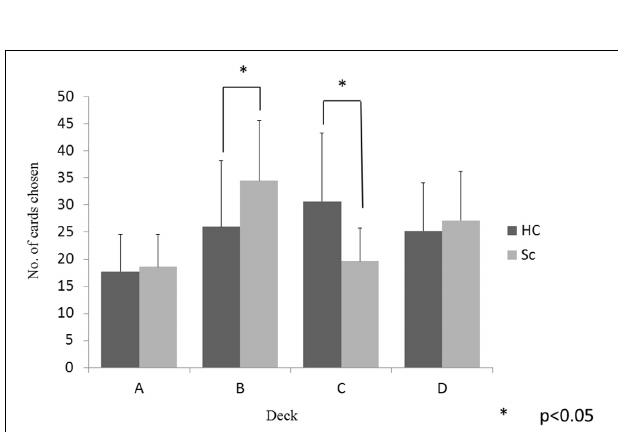
FIGURE 2 | Number of card choice selected from each deck during the 100-card